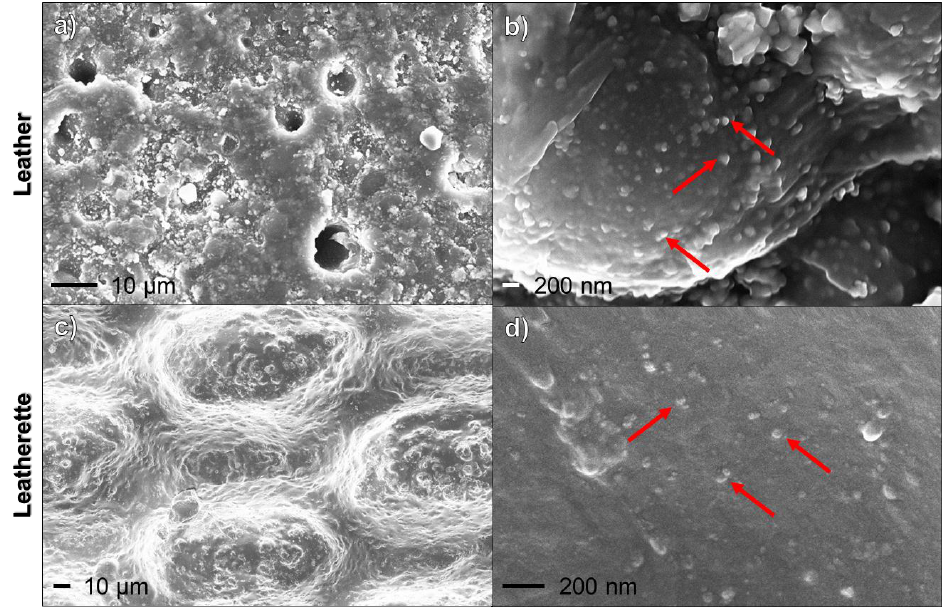
Figure 1. Scanning electron microscopy (SEM) morphological characterization of Ag-modified leather (( a , b ) panels, different magnifications) and leatherette (( c , d ) panels, different magnifications) samples. Arrows highlight inorganic clusters on samples surfaces.